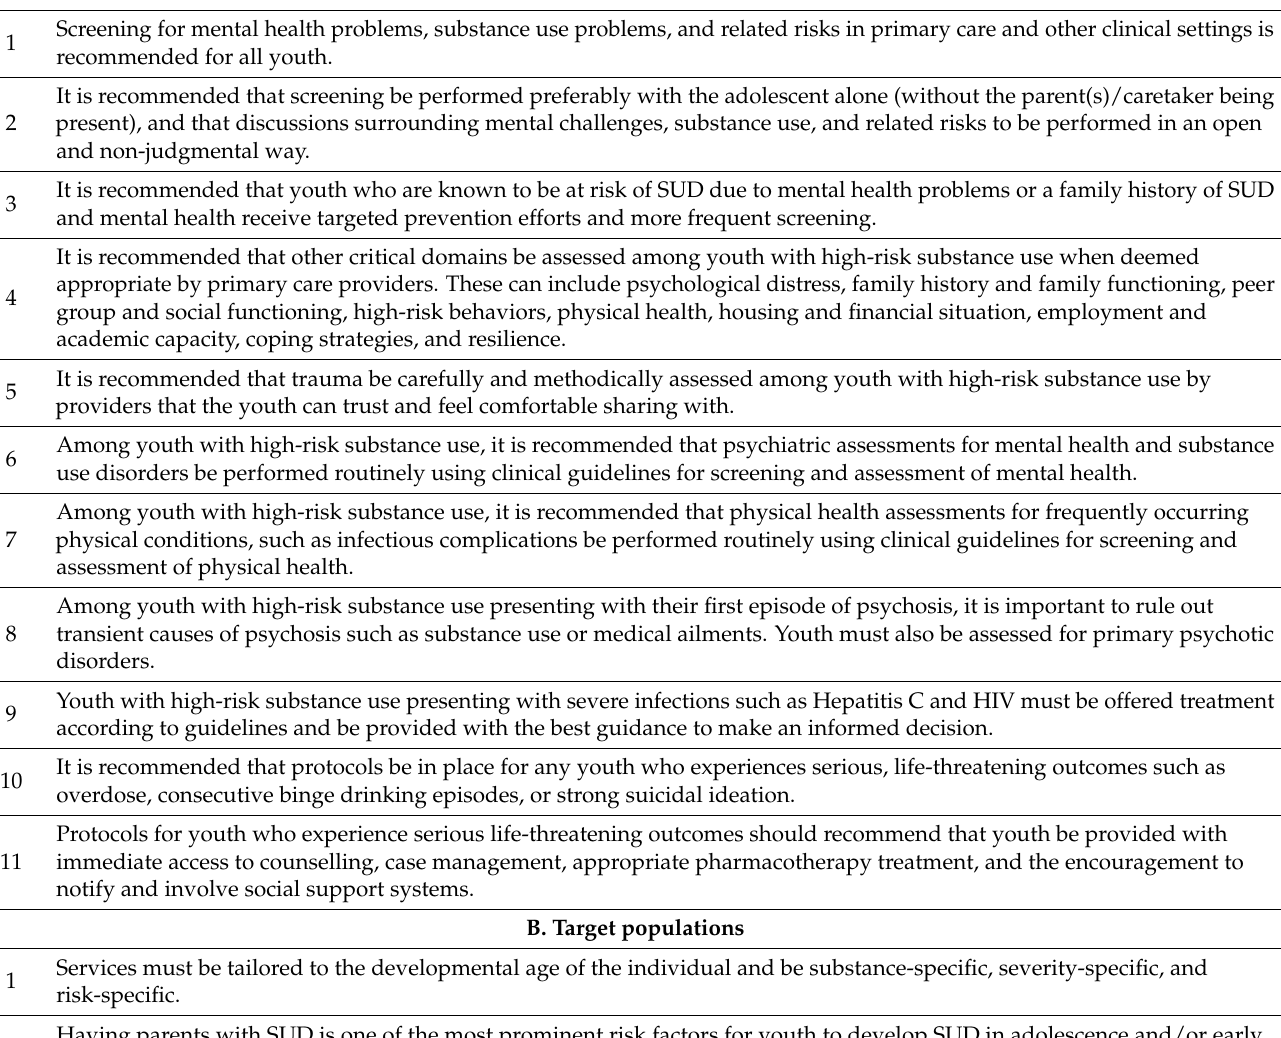
Table 2. Sixty consensus statements on the prevention, treatment, and management of high-risk substance use among